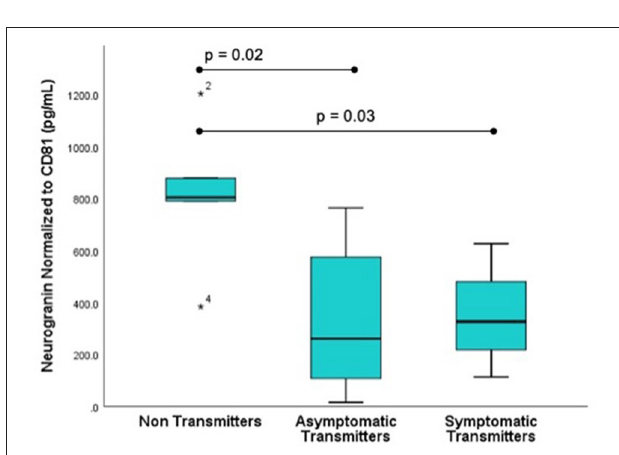
FIGURE 3 | Fetal CNS ECV neurogranin levels by clinical outcome. ECV protein levels of neurogranin normalized to CD-81 were compared in three groups: Non-transmitters (NT, n = 5), asymptomatic transmitters (AST, n = 5), and symptomatic transmitters (ST, n = 4). ANOVA testing was used to compare means. The p -value for significance was set at 0.05. * value outside the interquartile range.